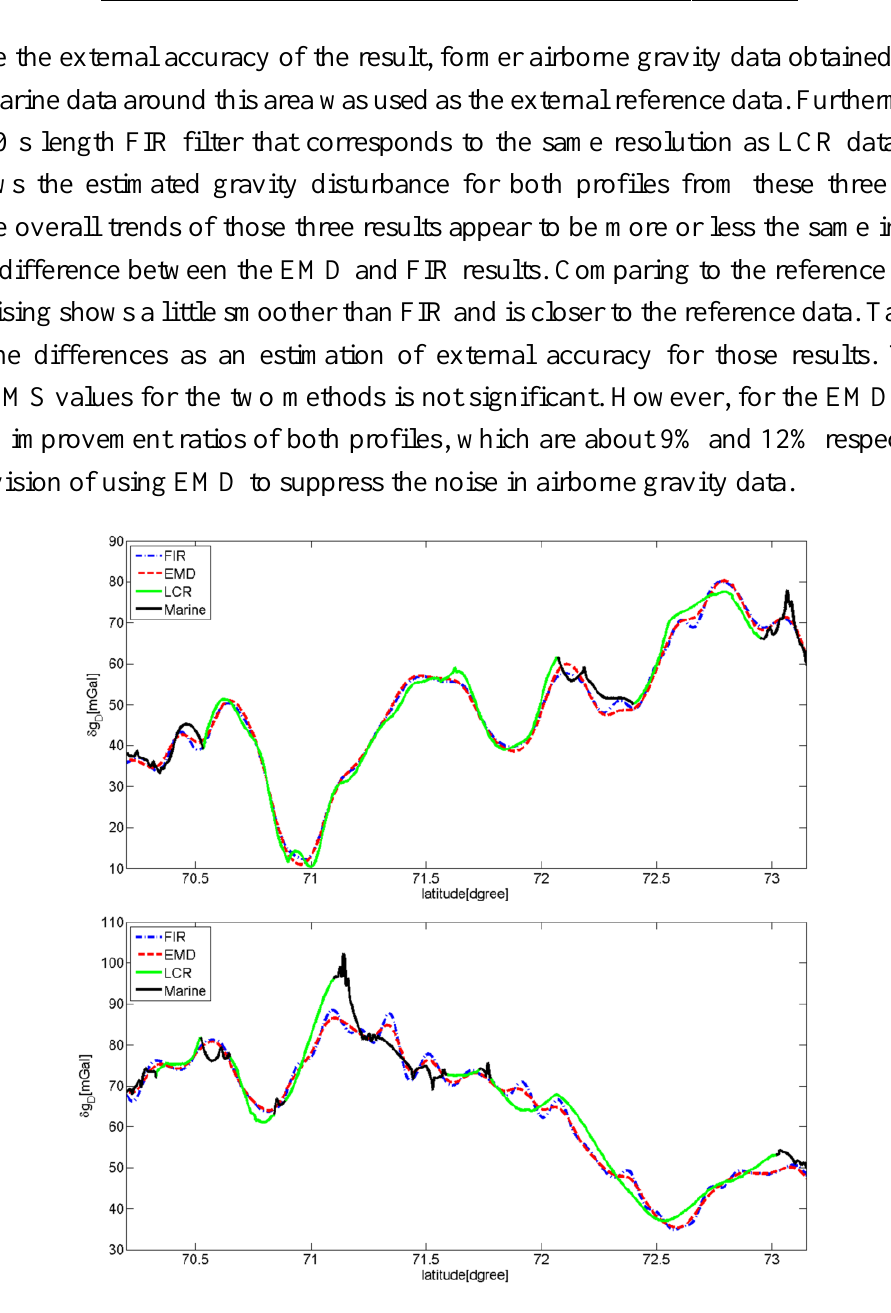
Figure 8. Comparisons between the estimated results of FIR, EMD and reference data. The blue line denotes the FIR denoising result, the red line represents the result of EMD denoising, the green line is LCR data and the black one is marine data. ( Top ) is the repeated flight A and ( bottom ) is flight B